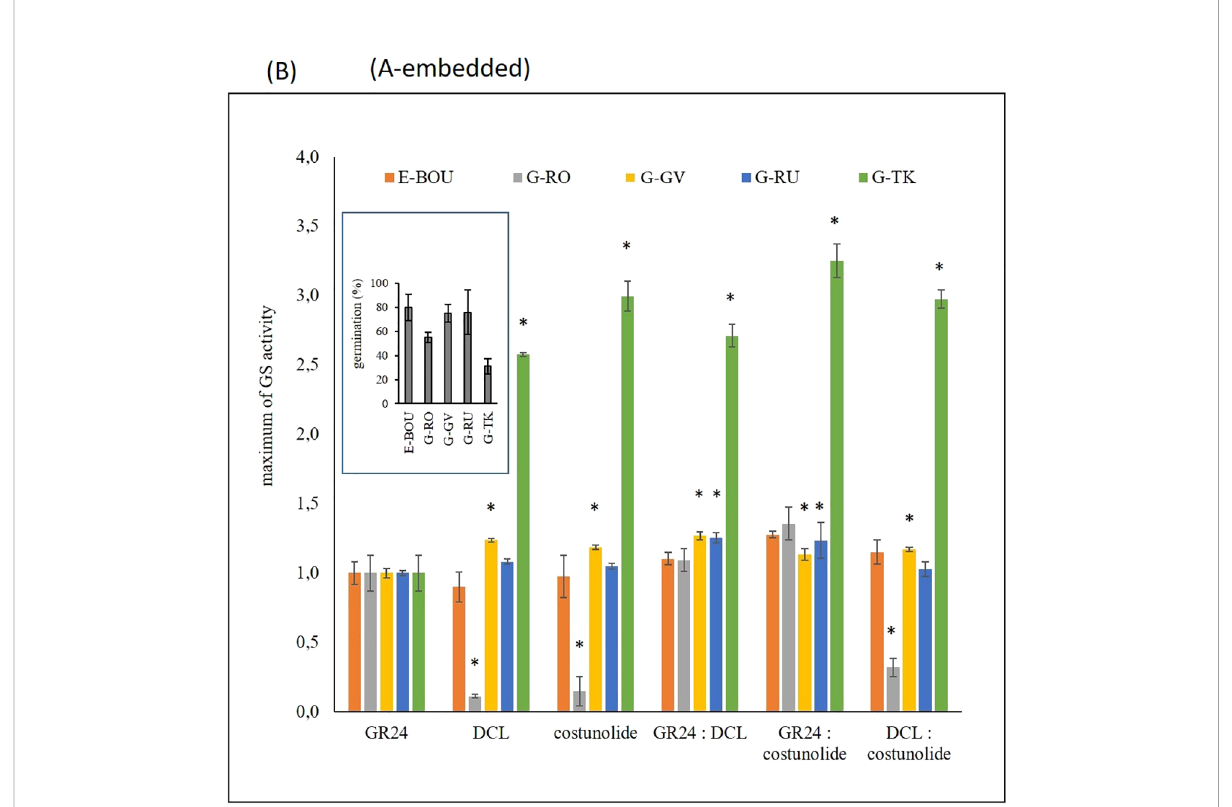
FIGURE 1 Seed germination of fi ve O. cumana populations in response to various germination stimulants (A) . Percentage of seed germination of fi ve O. cumana populations upon treatment with 1 µM GR24 (bar: ± SE). These results were used to normalize the germination stimulant activity in order to generate the dose-response curves (Supplementary File 5). (B) Maximum of germination stimulant activity of GR24, DCL, costunolide and equimolar mixtures of these compounds on the seeds of the fi ve O. cumana populations (bar: ± SE) were determined from the dose- response curves (Supplementary File 6). Holm-Sidak method was used versus the control group (asterisks indicate signi fi cant differences between GR24 and compounds or mixtures (p < 0.05) for each